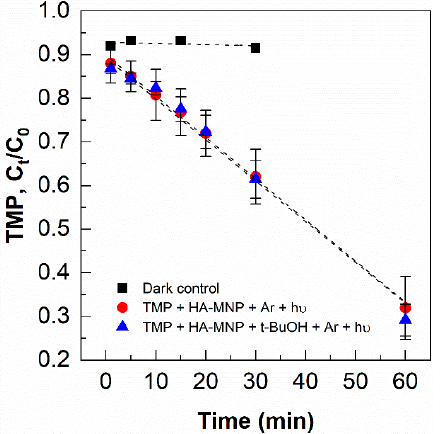
Figure 5. Triplet state-induced photodegradation of TMP in the presence of UVA and [HA-MNP] = 1.0 g L − 1 ; [TMP] 0 = 50 µ M, argon saturated; error bars represent the standard deviation of triplicate measurements.